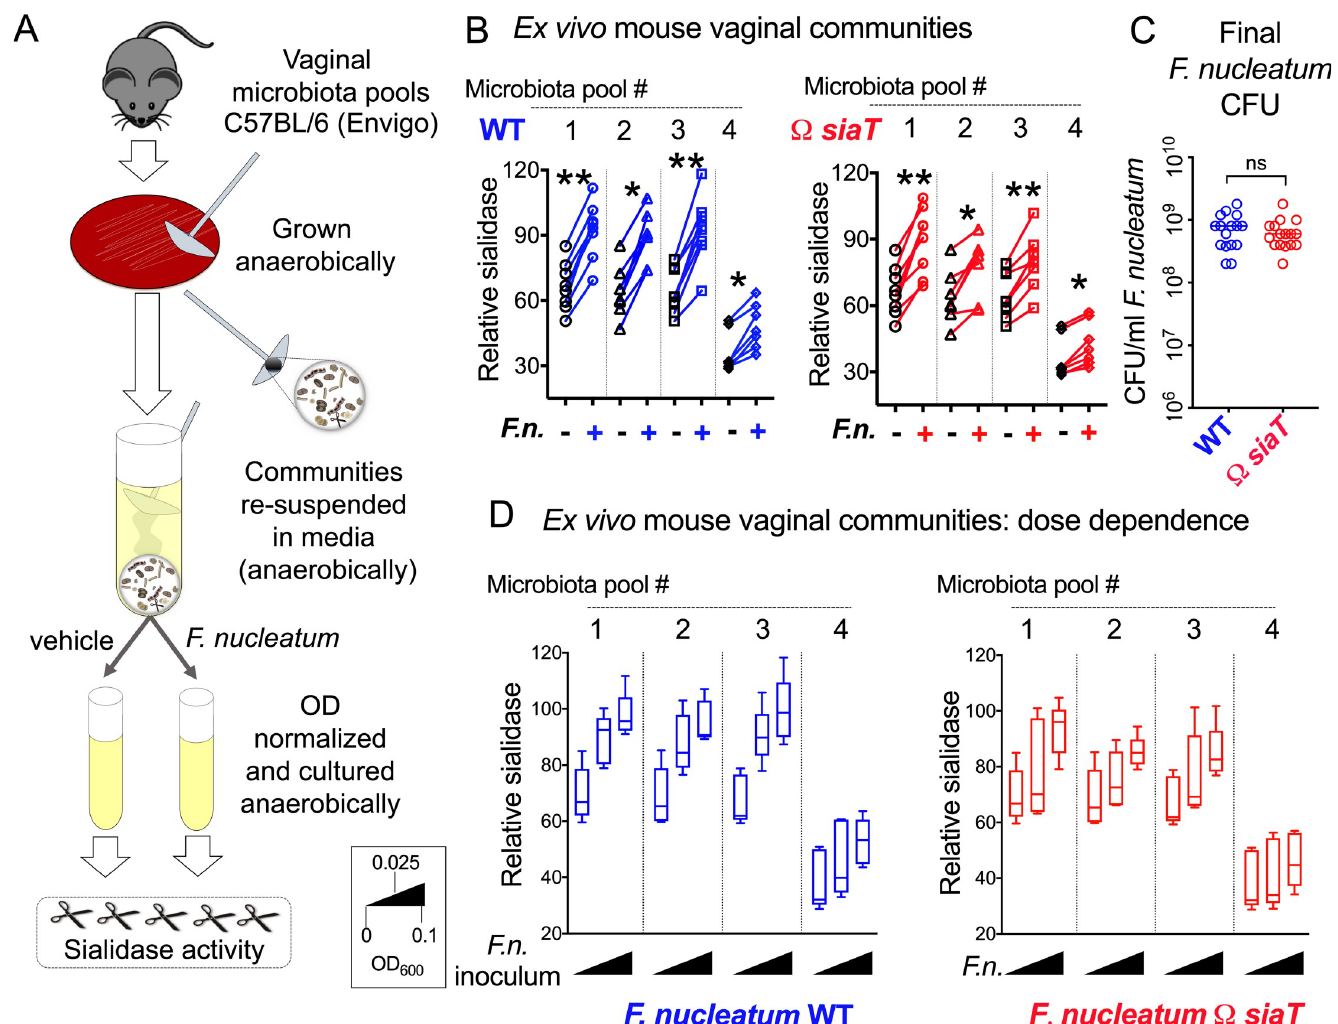
Fig 6. Ex vivo interaction between F . n . and the mouse vaginal microbiota leads to enhanced sialidase activity. (A) Microbiotas from vaginal washes were collected from mice prior to inoculation in Fig 4B, pooled (by cage), cultured, and frozen (S1 Schematic, Step 1). Bacteria were recovered from frozen microbiota pools by streaking them on supplemented Columbia blood plates anaerobically and incubating for 24 h at 37˚C. Microbial growth was gently scraped from these plates and resuspended in liquid media to prepare OD-normalized inocula and cocultured with F . n . WT or O siaT overnight (approximately 16 h). (B) Sialidase activity in microbiota pools from Envigo mice, cultured in the presence or absence of F . n . Each “microbiota pool” consists of a cultured vaginal community from pooled vaginal wash of 4–5 cohoused mice. Wilcoxon paired-sign rank test was used for pairwise comparison. Data shown are combined from 4 independent biological replicates with 7–8 technical replicates for each microbiota pool. � P < 0.05, �� P < 0.01. (C) F . n . titers after overnight growth with microbiota pools from Envigo mice. (D) Dose- dependent boost in sialidase activity in microbiota pools from Envigo mice, cultured in the presence or absence of F . n . (inocula high to low: OD 600 0.10 or 0.025 or no F . n .). Line in the box indicates median value. Data shown are representative of 3 independent experiments. The underlying numerical data for this figure can be found in S1 Data. CFU, colony-forming unit; F . n ., F . nucleatum ; OD, optical density; siaT , predicted sialic acid transporter; WT, wild type.